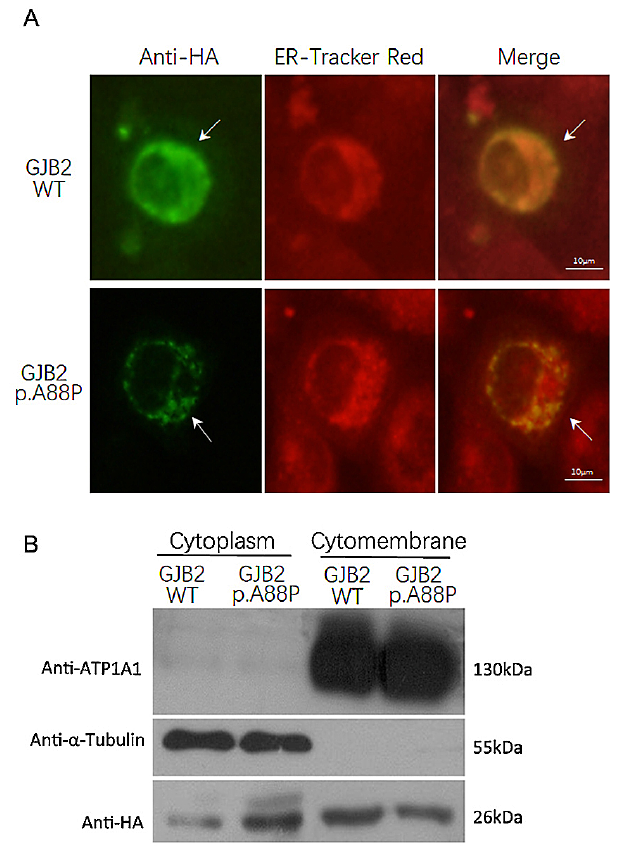
Figure 3. Expression ofthe p.A88PCx26mutants incells. Theimmunofluorescence staining showed thewild-type GJB2 was expressed robustly and distributed mainly in the cytomembrane, while the p.A88P mutant was expressed weakly and displayed a punctate distribution in the cytoplasm and cytomembrane (A, arrow); the ER tracker red demonstrated the cytoplasm (A). The immunoblotting confirmed the wild-type GJB2 largely localized in the cyto- membrane, while the p.A88P mutants co-localized in the cytoplasm and cytomembrane